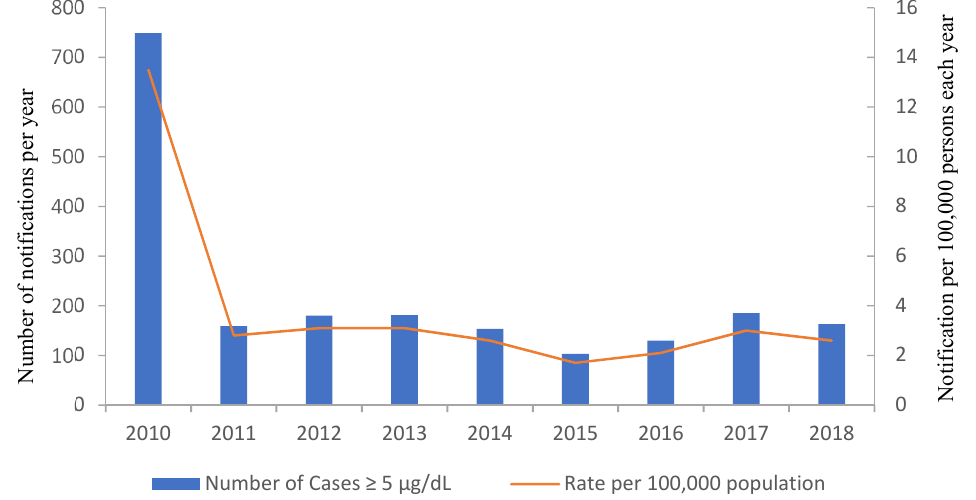
Figure 1. Yearly notifications to Victorian Health of blood lead level measurements of persons reported levels above 5 µg/dL for the years 2010–2018. The number of notifications per 100,000 population are also listed. Source: https://www2.health.vic.gov.au.